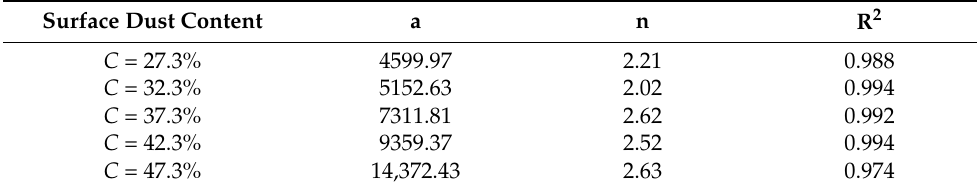
Table 1. Regression coefficients in Equation